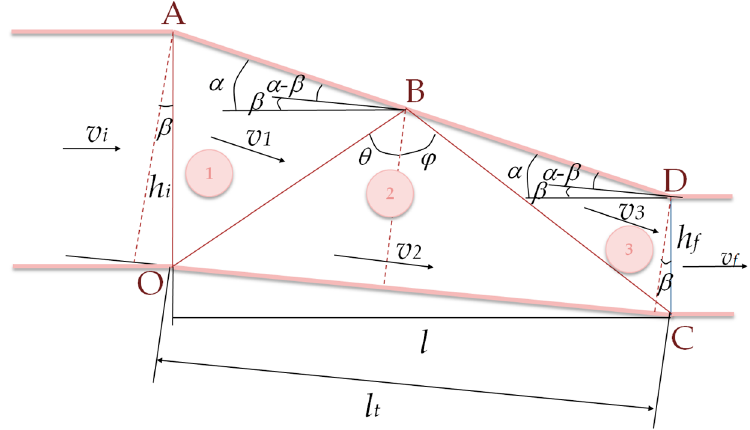
Figure 3. Modelling of the plastic deformation zone with three triangular rigid zones.